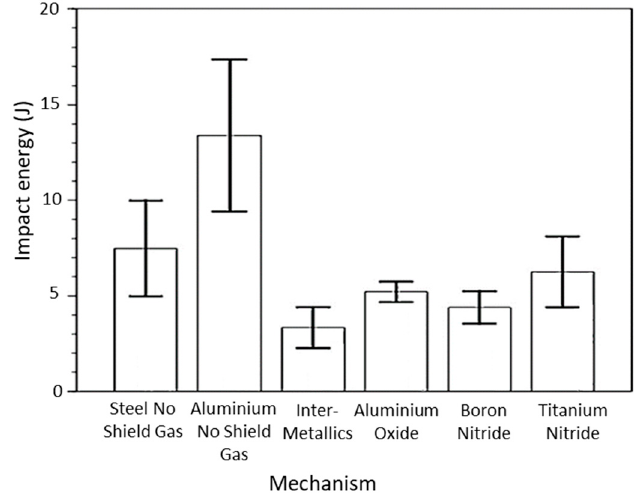
Figure 8. Impact energy test results of the samples built with different strategies and coatings (adapted from [38]).